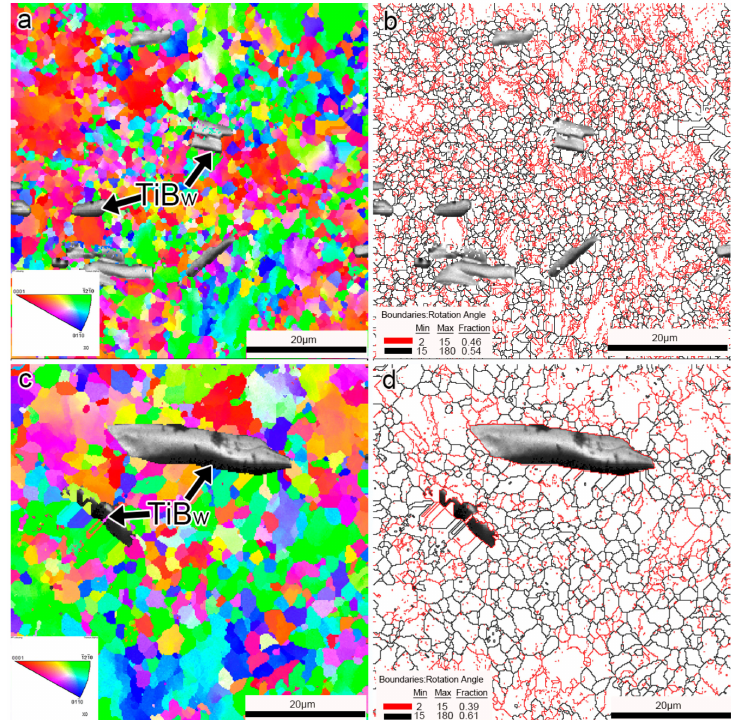
Figure 7. Inverse pole figure and grain boundary map of 7.5 vol.% TiB w / near α -Ti composite: ( a , b ) deformed at 800 ◦ C / 0.01 s − 1 , ( c , d ) deformed at 900 ◦ C / 0.01 s − 1